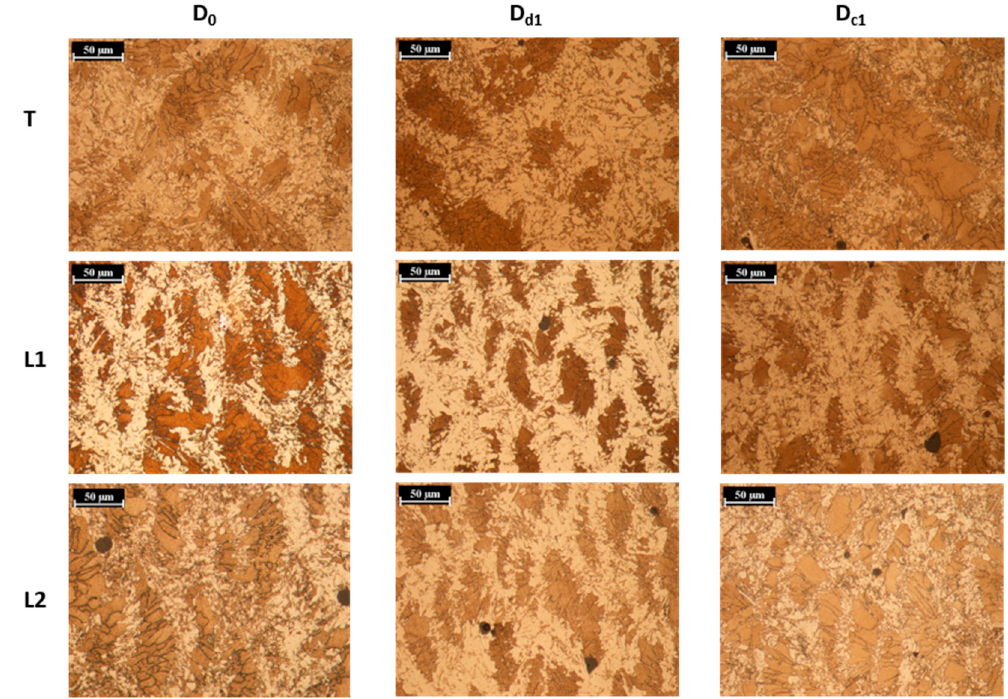
Figure 2. Microstructure of the D 0 , D d1 , and D c1 specimens in the T, L1, and L2 sections after the Vilella chemical etching.